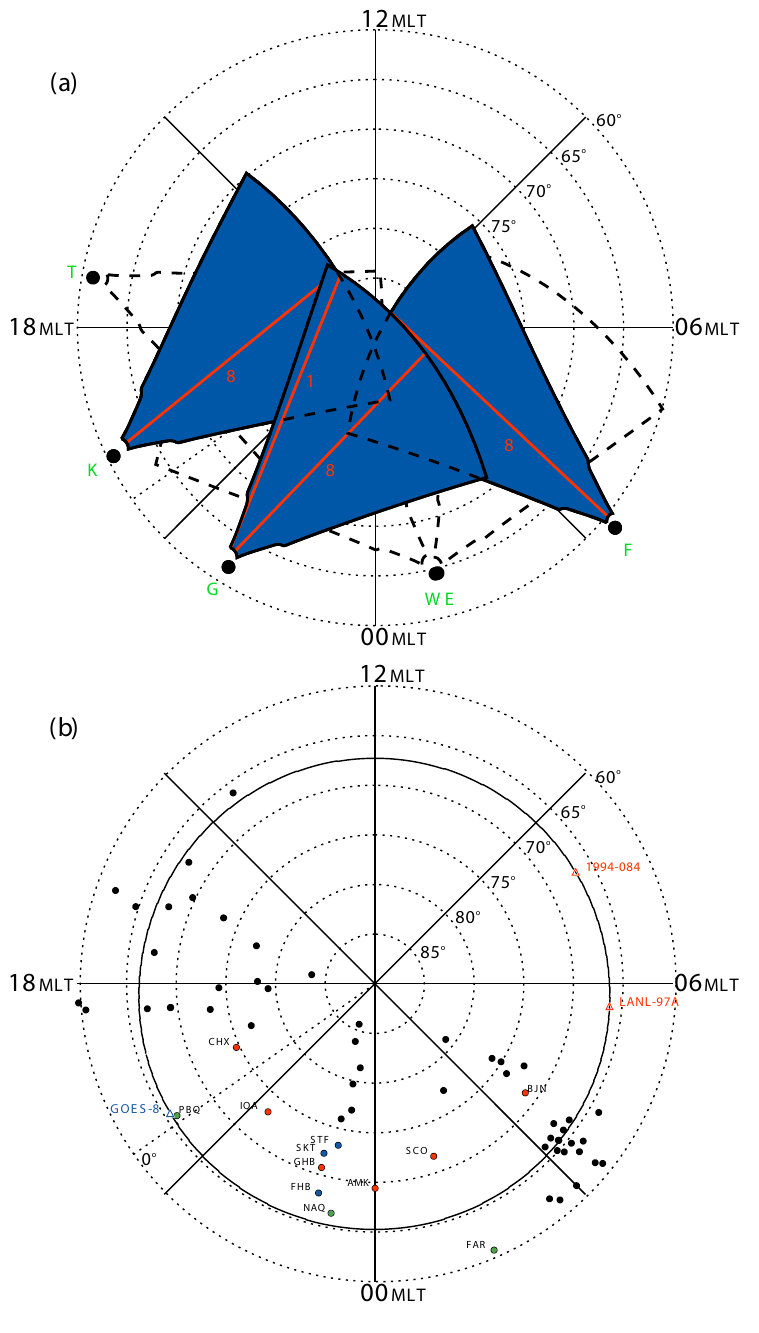
Fig. 1. (a) Fields-of-view of the six Northern Hemisphere SuperDARN radars at 01:00UT, plotted on a geo- magnetic grid from the pole to 60 ◦ , with 12MLT at the top and dusk to the left. Fields-of-view coloured blue are those of the three radars for which de- tailed line-of-sight measurements will be discussed, using the beams indi- cated in red. (b) Shows ground-based magnetometer locations and geostation- ary spacecraft footprints at 01:00UT on the same grid. Coloured magnetome- ter locations are those for which time- series plots will be shown. Green dots indicate stations whose data has been band-pass filtered to provide informa- tion on Pi2 signals. Red dots indicate stations which form a longitude chain at ∼ 70 ◦ –75 ◦ , which define the local time extent of the principal magnetic disturbance. Blue dots indicate sta- tions of the Greenland west coast lati- tude chain (additional to GHB and NAQ which are coloured red and green as just indicated), which define the latitu- dinal extent of the main magnetic dis- turbance. The black oval represents the ionospheric footprint of geostationary orbit (specifically that of the GOES-8 spacecraft). On it are plotted the loca- tions of the GOES-8, LANL-97A, and 1994-084 Fig. 1